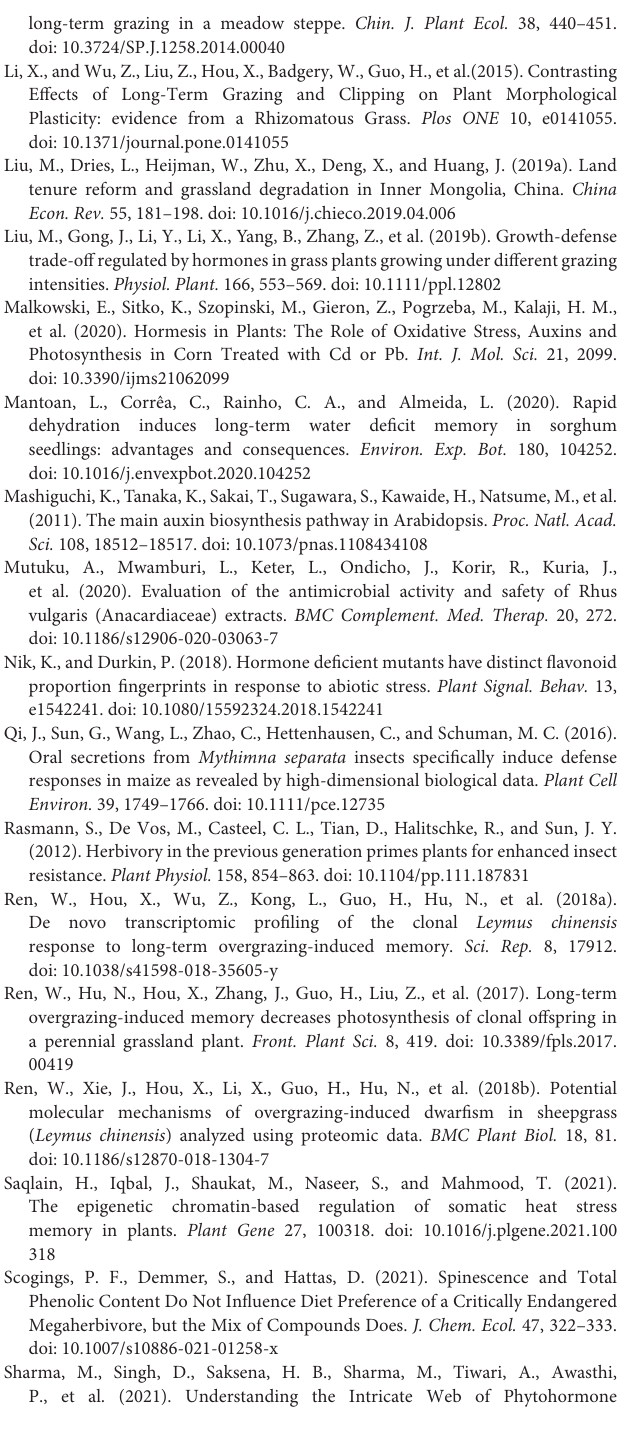
Supplementary Figure S1 | Expression levels of auxin (IAA), gibberellic acid (GA), and abscisic acid (ABA)-related genes. Supplementary Figure S2 | The activity of peroxidase (POD) and superoxide dismutase (SOD) in roots and leaves in response to two conditions. ∗∗∗ P < 0.001; 0.001 < ∗∗ P < 0.05; ∗ P <